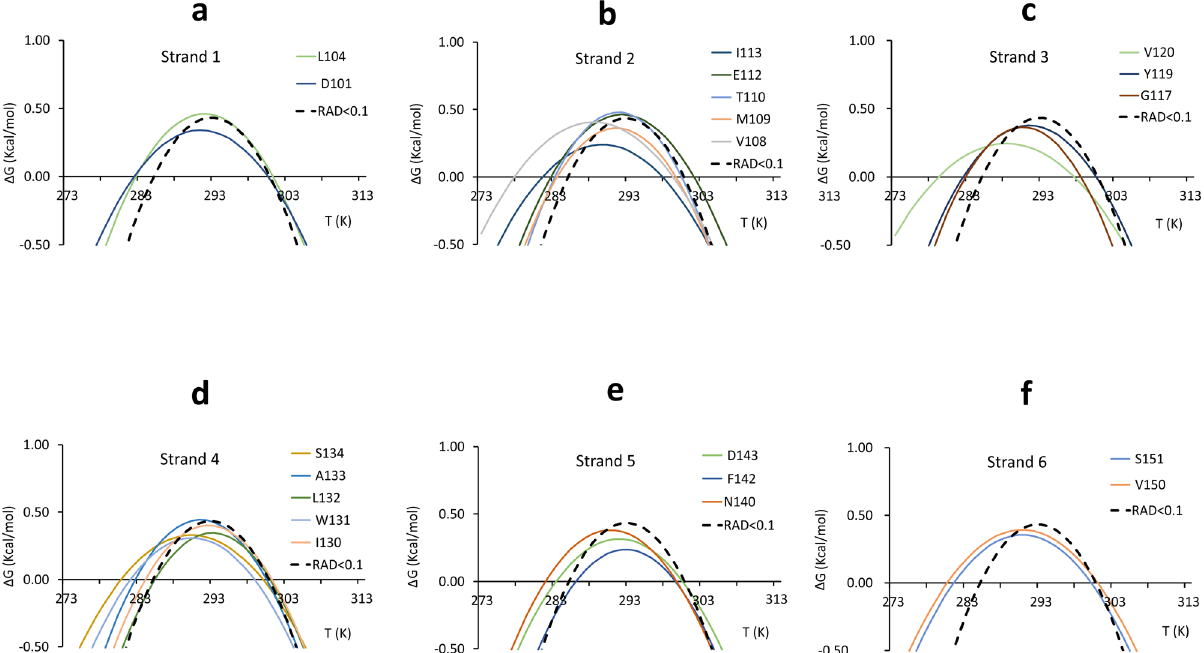
Fig. 5 Stability curves of residues belonging to secondary structure elements. a Strand 1. b Strand 2. c Strand 3. d Strand 4. e Strand 5. f Strand 6. Residues are labelled with a single letter code. The average stability curve is shown as a black dashed